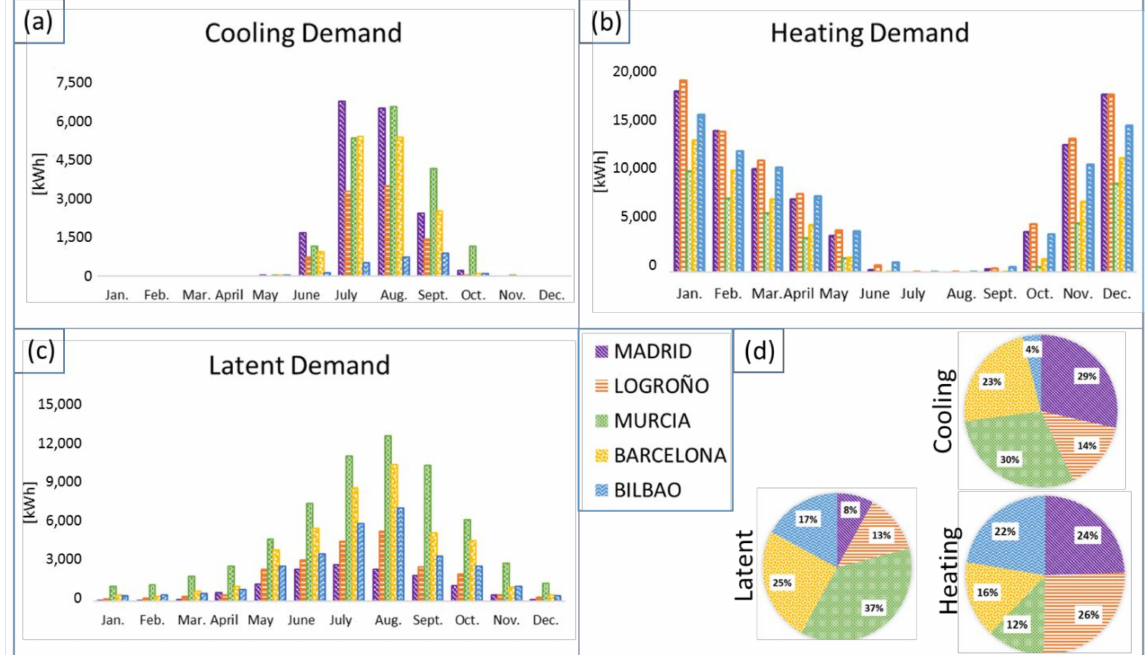
Figure 13. Monthly ( a ) cooling, ( b ) heating and ( c ) latent demand of the office and ( d ) relative demands in the 5